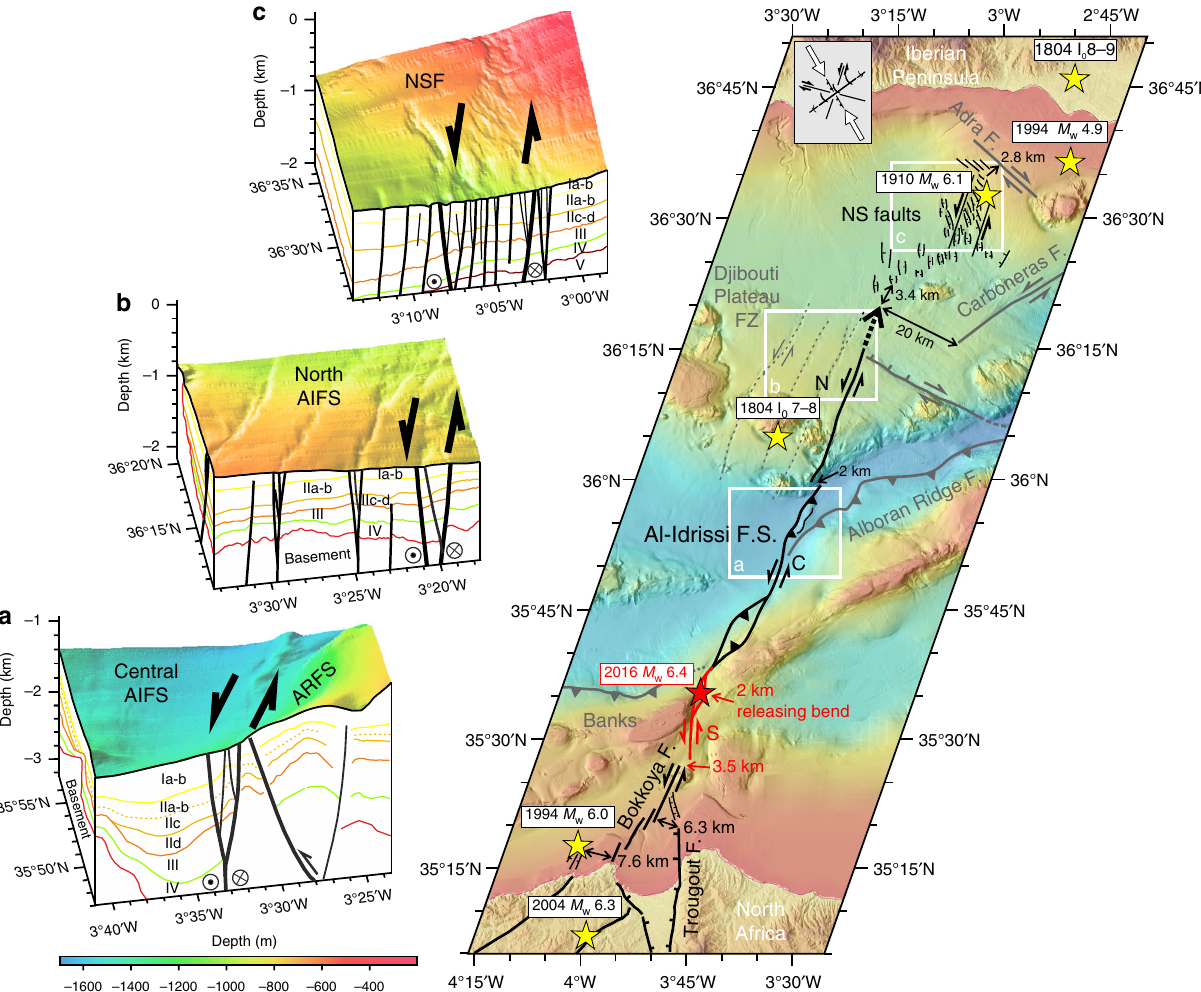
Fig. 7 Evolutionary stages of AIFS and conceptual model of fault growth. Traces of active fault segments that likely ruptured during the 2016 earthquake are shown as red lines. Red star: mainshock; Yellow stars: epicentres of previous large magnitude earthquakes: 1994 9, 10 and 2004 events in north Morocco 11 , 1804 (Djibouti I 0 7 – 8 and Adra I 0 8 – 9) 15 , 1910 (NSF) 25 and 1994 (Adra) 15 events in south Spain. Red and black arrows point to fault gaps and steps measured perpendicular to the fault strike. Offsets are labelled. The boundaries between the AIFS segments are depicted by dashed red lines. a – c are three- dimensional views representing snapshots of the AIFS evolutionary